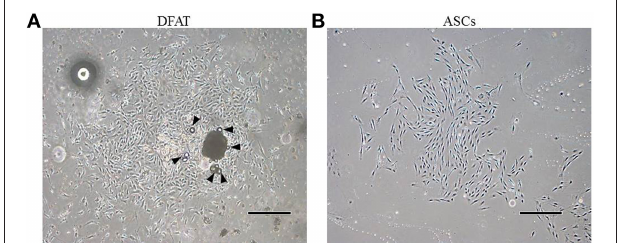
FIGURE 3 | Morphology of primary cultured DFAT cells and ASCs. (A) When the flasks had been inverted for 7 days, DFAT cells grew to form a colony. Some DFAT cells in the colony still have a lipid droplet (arrowheads). Scale bar = 500 µ m. (B) Cultured ASCs are more spindle-shaped than DFAT cells. Scale bar = 500 µ